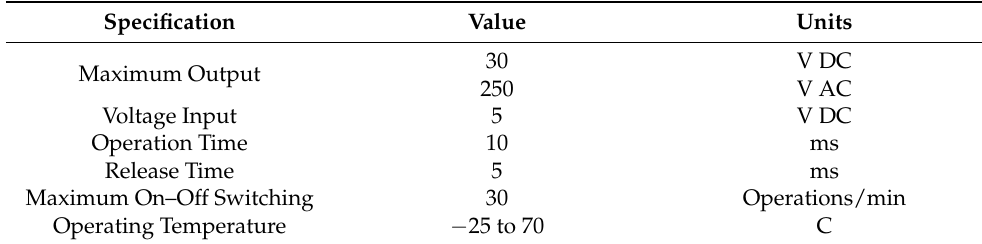
Table 6. Relay module technical specifications [36].